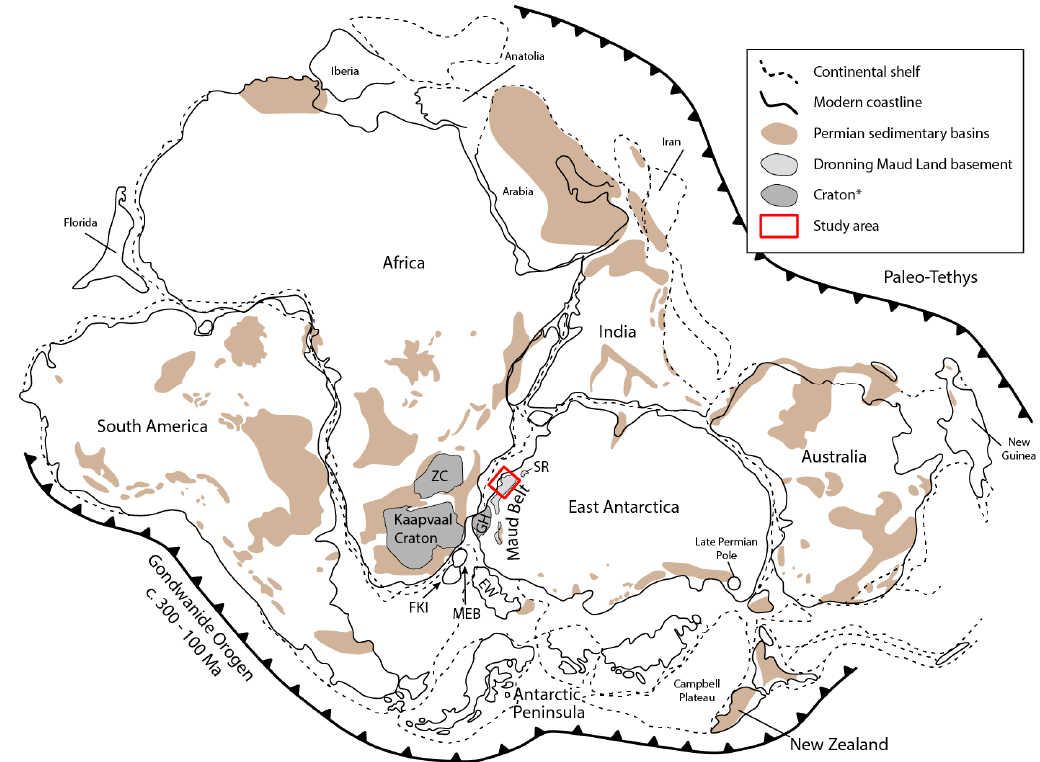
Figure 1. Gondwana reconstruction during Permian times, showing the distribution of Permian sedimentary basins. * Only cratons that were part of the Kalahari Craton are shown. Abbreviations: EW—Ellsworth-Whitmore Mountains crustal blocks; FKI—Falkland Islands; GH—Grunehogna